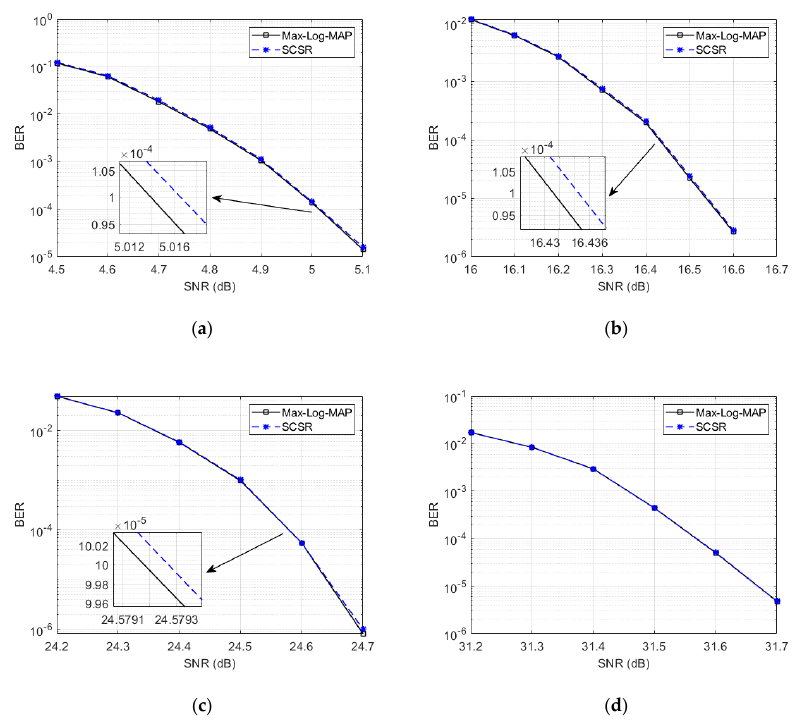
Figure 7. BER Performance comparison of Max-Log-MAP and SCSR demapping algorithms over i.i.d Rayleigh channel. Results presented for 1D-1024NUCs. ( a ) CR = 2/15; ( b ) CR = 6/15; ( c ) CR = 10/15; ( d ) Rayleigh channel. Results presented for 1D-1024NUCs. ( a ) CR = 2 / 15; ( b ) CR = 6 / 15; ( c ) CR = 10 / 15; CR = 13/15. ( d ) CR = 13 /